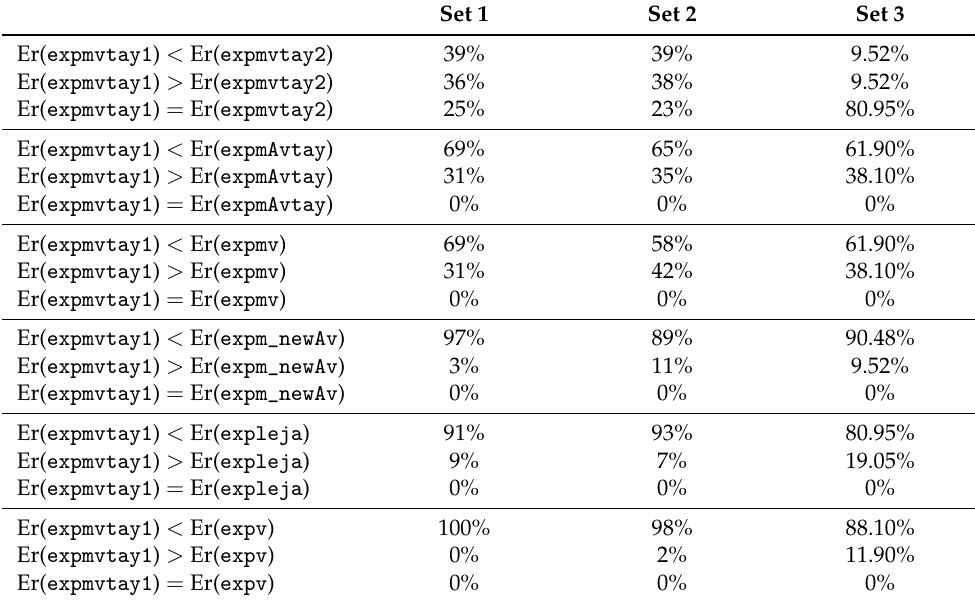
Table 2. Normwise relative error comparison, for the three sets, between expmvtay1 and all other